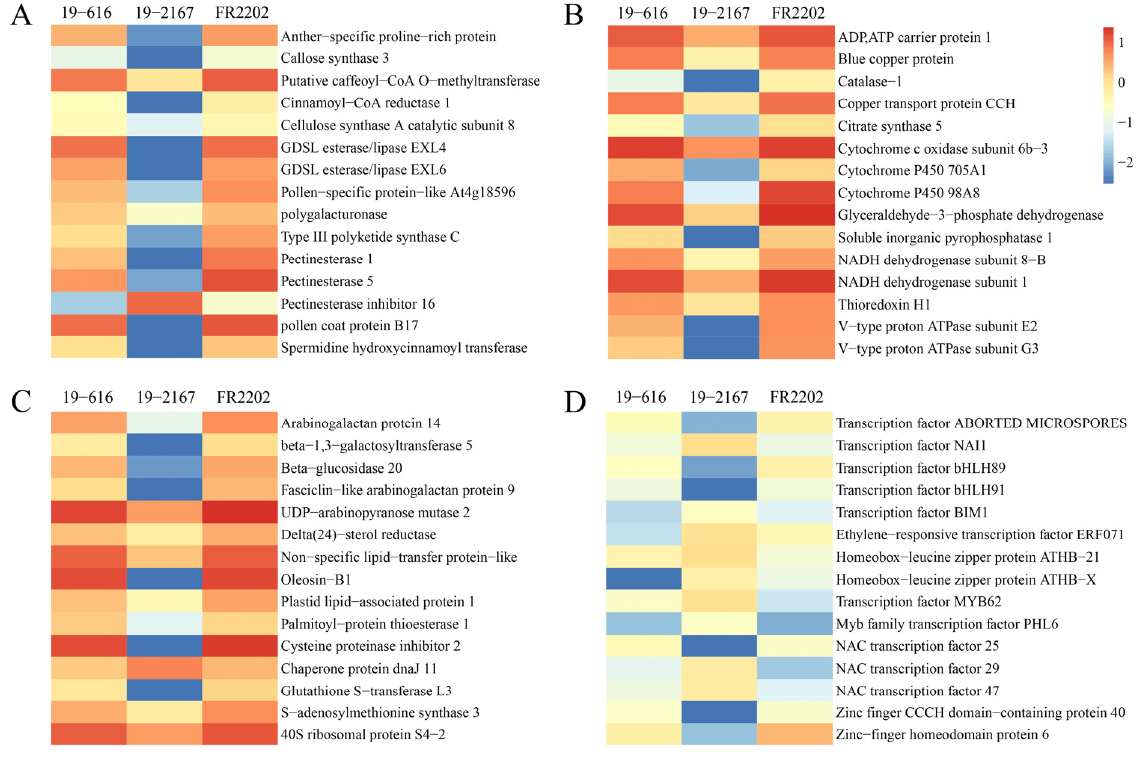
Figure 5. The expression trends and annotations of DEGs enriched in pollen development ( A ); energy metabolism ( B ); carbohydrate, lipid, and protein metabolism ( C ); and transcription factors ( D ).